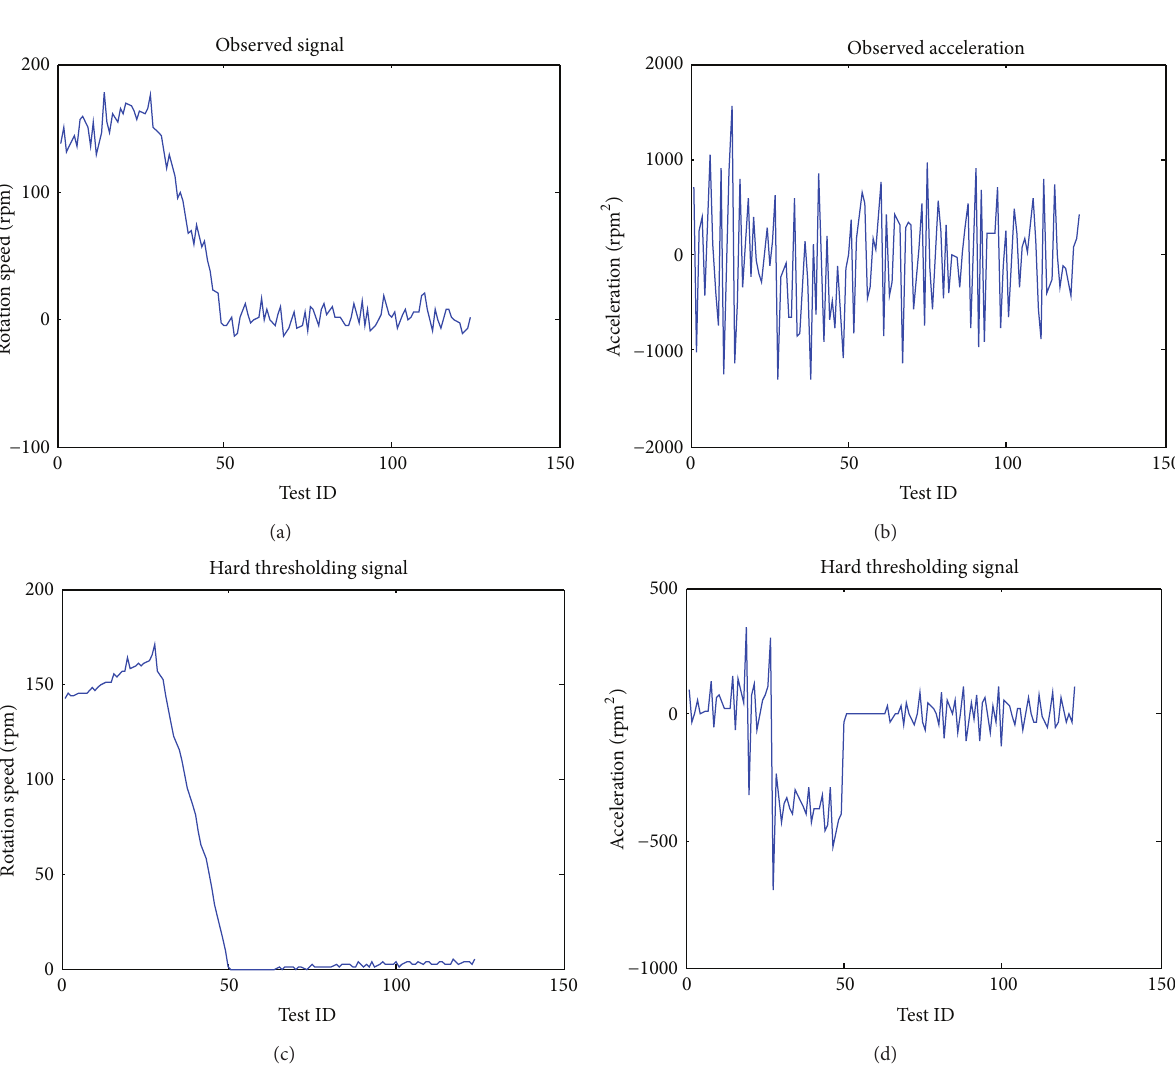
Figure 7: Comparisons of rotation speed and